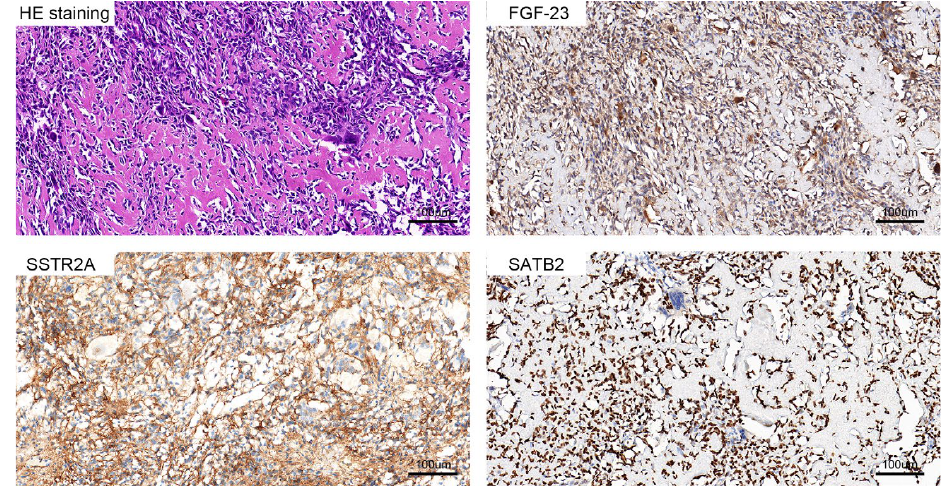
Figure 3. The results of the pathological examination of PMT showed that the staining was mostly spindle cells and bone-like matrix components, and the immunohistochemical staining of FGF23, SSTR2A, and SATB2 was strongly